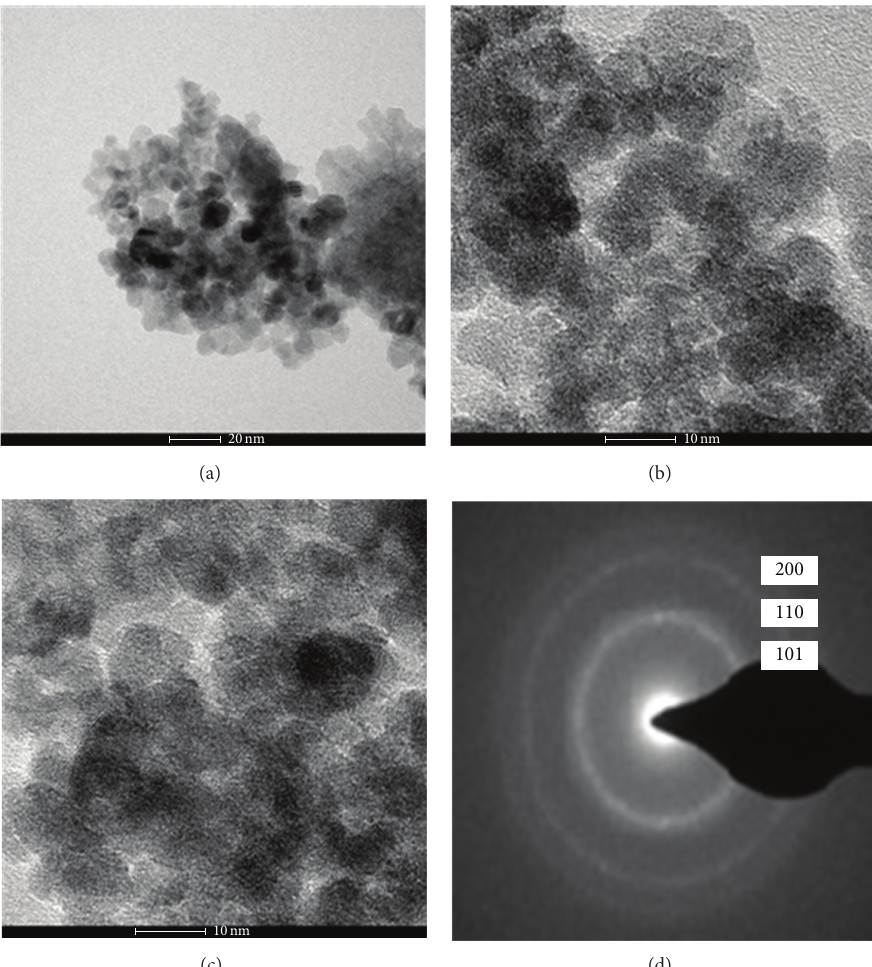
Figure 5: TEM micrographs of ZrO 2 NPs at different magnifications (a)–(c) and electron diffraction pattern taken on a selected area of the sample